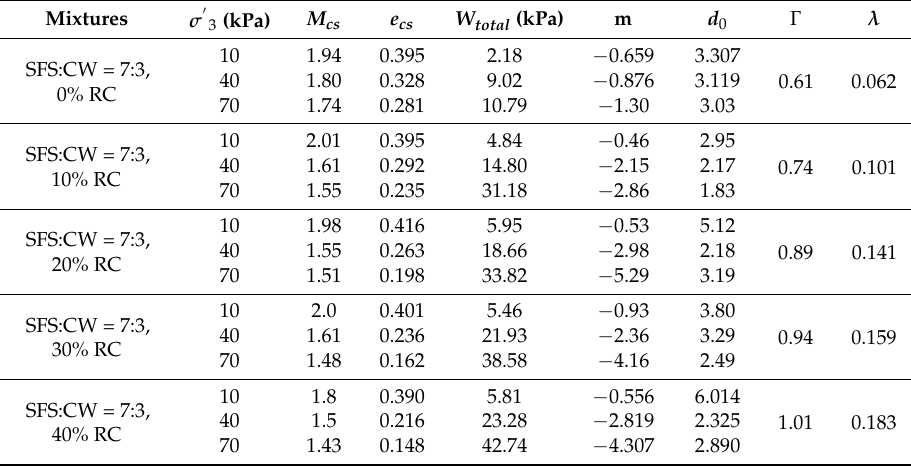
Figure 5. ( a ) 𝑒 − 𝑝′ curves of SFS+CW+RC mixtures at critical state; ( b ) relationship of Γ and 𝜆 in Figure 5. ( a ) e − p (cid:48) curves of SFS+CW+RC mixtures at critical state; ( b ) relationship of Γ and λ in terms terms of 𝑅 (cid:3029) (modified after Qi et al. [43]). of R b (modified after Qi et al. [43]). Table 2. Dilatancy model parameters for SFS+CW+RC mixtures [43]. Table 2. Dilatancy model parameters for SFS+CW+RC mixtures